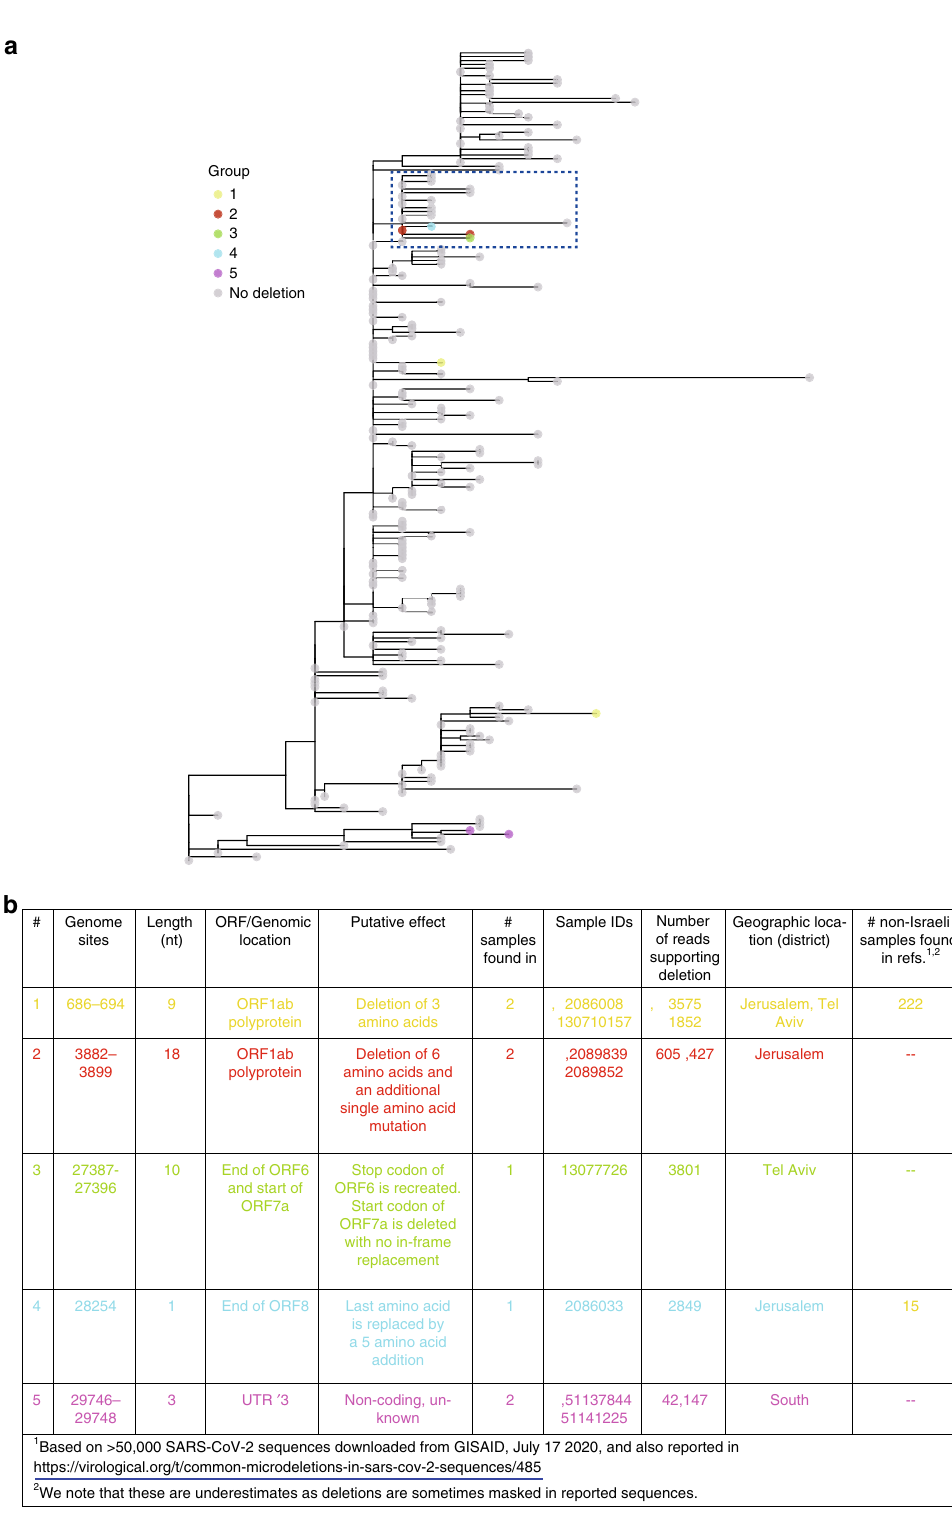
Fig. 2 Deletions found in Israeli samples. a Maximum-likelihood tree of Israeli sequences highlighting sequences found with deletions. Sequences are color-coded by the groups described in b . A clade with three independent deletions occurring in four samples is boxed. Source data are provided as a Source Data fi